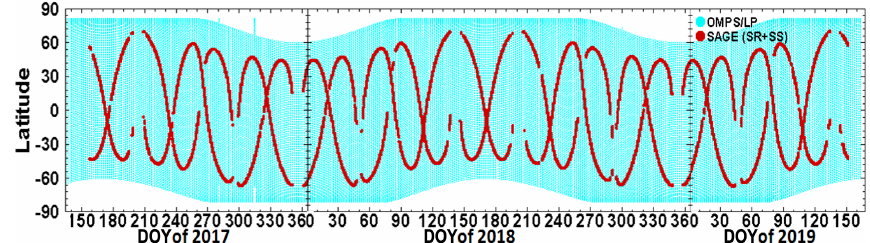
Figure 2. Time–latitude sampling pattern for OMPS/LP (light blue) and SAGE III/ISS (red) during the period from June 2017 to May 2019.